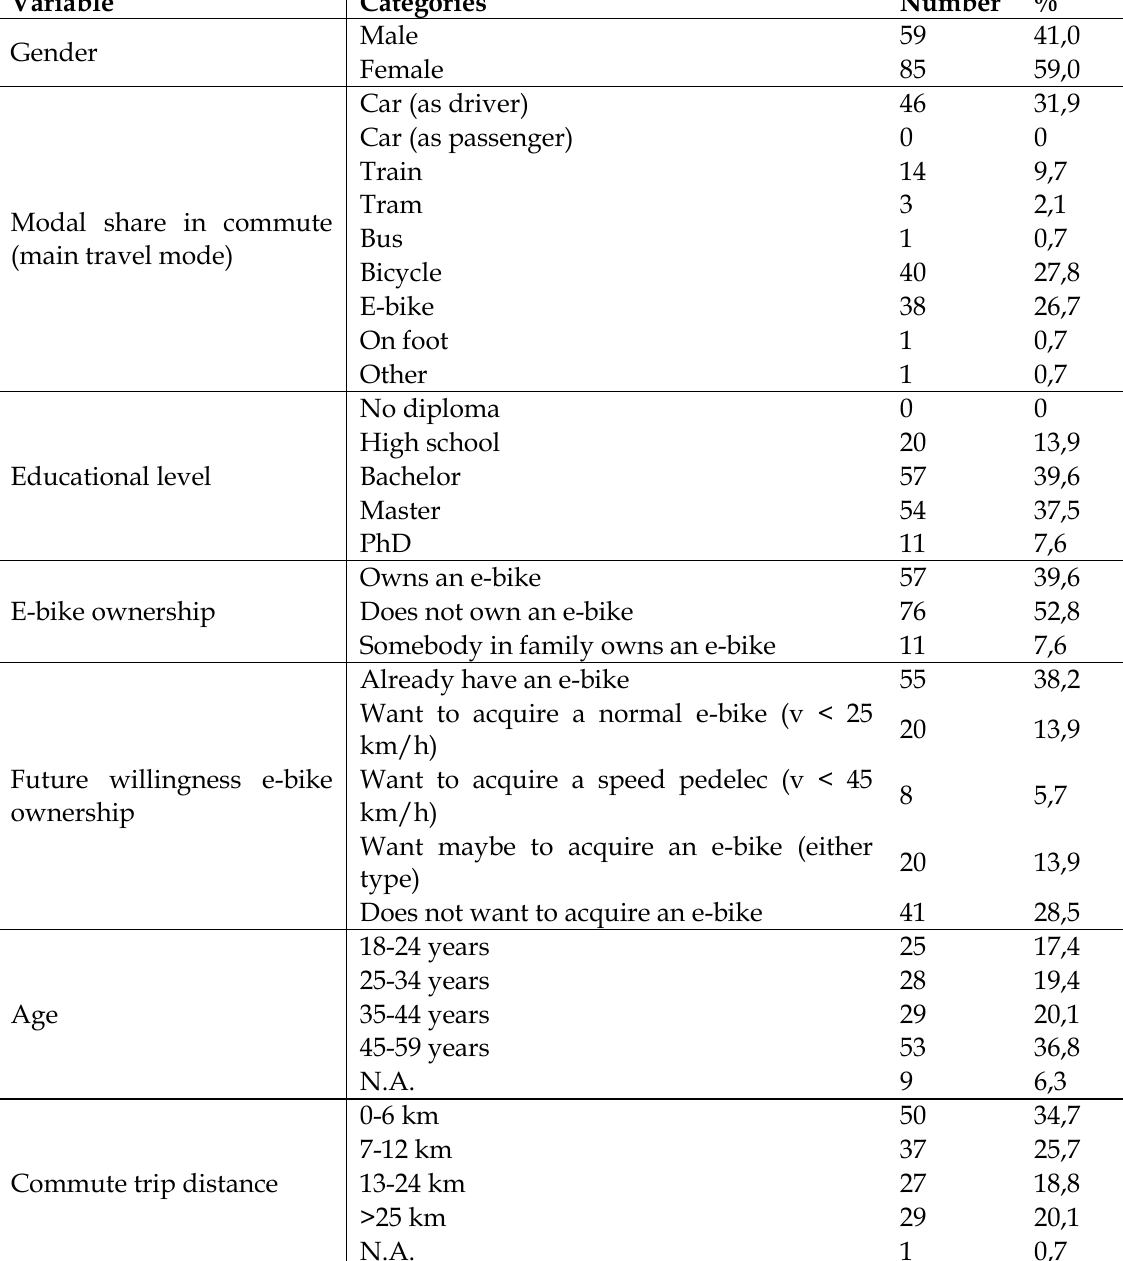
Table 2. General and E-bike Journey Characteristics (n = 144